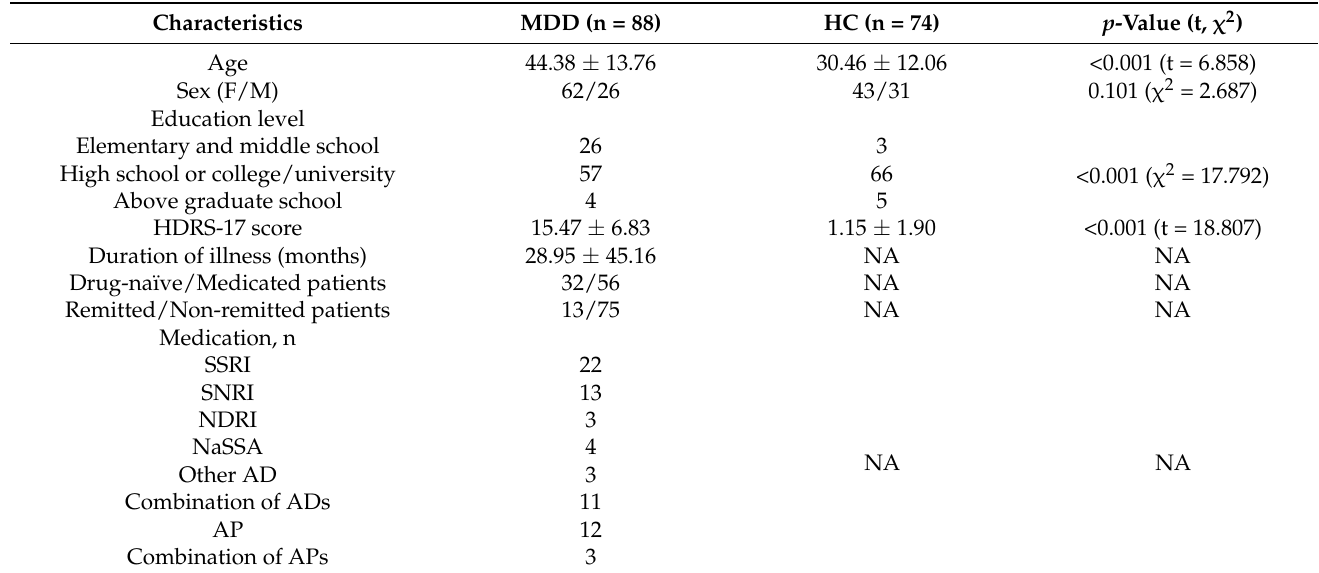
Table 1. Demographic and clinical characteristics of MDD patients and HCs included in the neu- roimaging analysis.